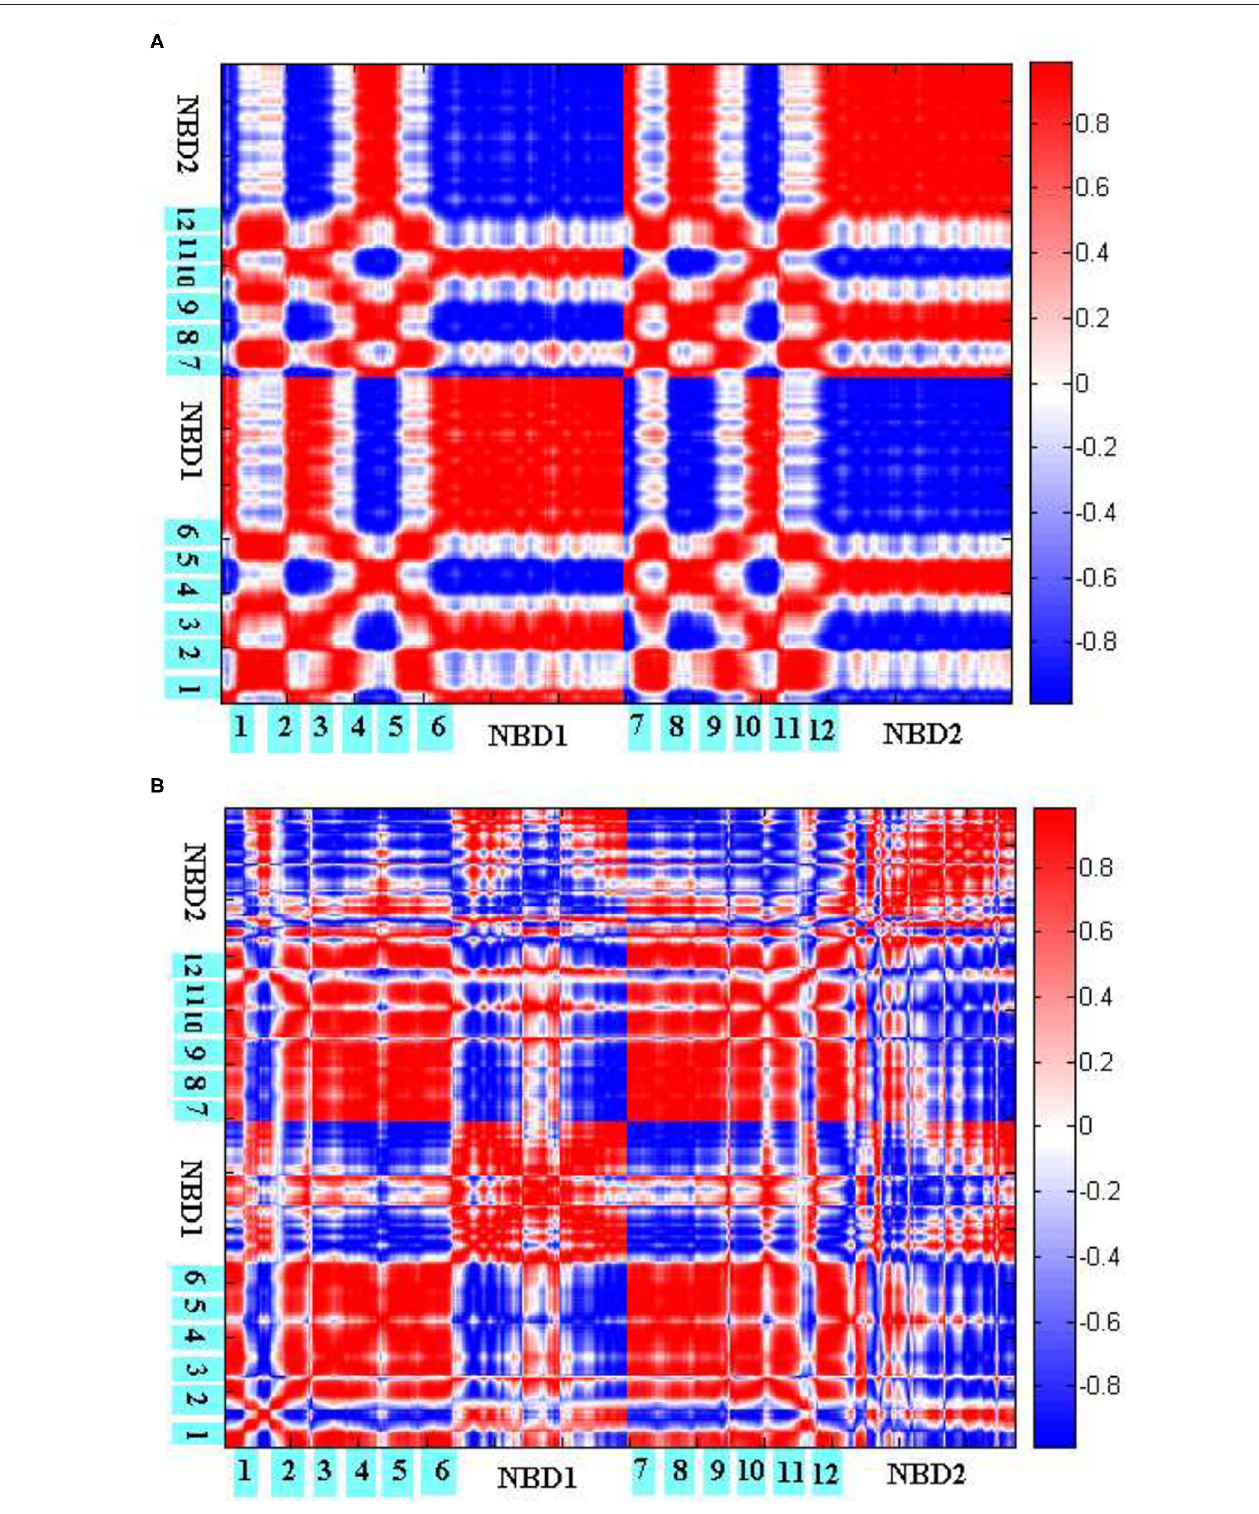
FIGURE 8 | Cross-correlations between the residues of P-gp in the initial (A) and final (B) stages of allosteric transitions. The TM helices TM1-6 and NBDs are labeled out.